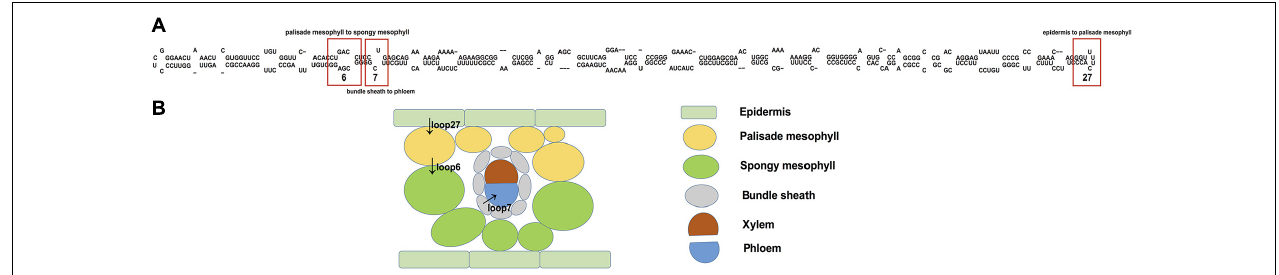
FIGURE 1 | Functional analysis of PSTVd secondary structure and pathways for systemic trafficking of PSTVd in an infected plant. (A) PSTVd consists 359 RNA nucleotides folded into a secondary structure, which contains 26 base pair stems and 27 loops. Loop 6, 7, 27 represent different unpaired single circular stranded regions of PSTVd . The nucleosides U43/C318 in PSTVd loop7 played a key role in mediating the transport of PSTVd from bundle sheath to phloem. The six nucleosides of loop 6, G36, A37, C38, C323, G324, and A325, when the mutated nucleosides (G36U/A37C/C38G) close loop 6, its systematic transport was limited, and loop 6 was very important for the transport of PSTVd from palisade mesophyll to spongy mesophyll. The U178G/U179G double mutant in loop27 has replication ability in tobacco cells, but it can only spread in the upper epidermis of inoculated leaves, suggesting that the bases in loop27 will affect the transport of PSTVd from epidermis to palisade mesophyll cells in N. benthamiana . (B) The black arrows illustrate the distinct steps of PSTVd cell-to-cell transport in leaves. Cell types are indicated on the right in B with different